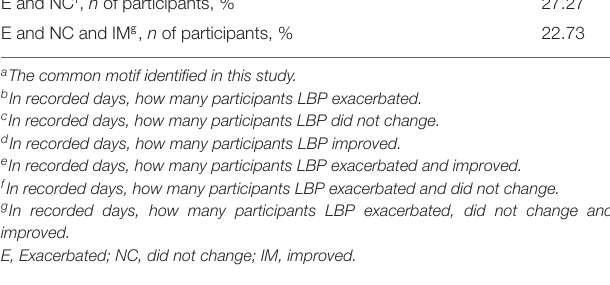
BIC, Bayesian information criterion.